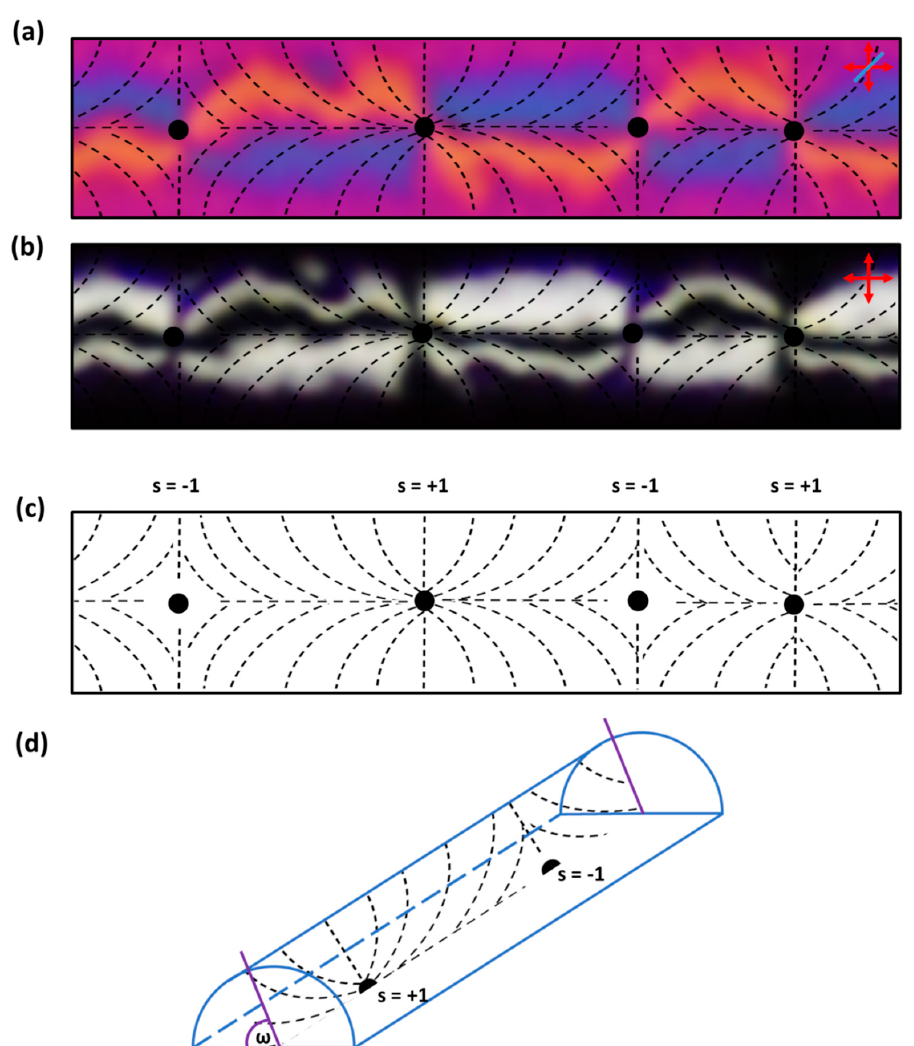
Figure 3. ( a – c ) show view from above of the escaped radial director field adopted by a nematic LC in a hemi ‐ cylindrical droplet, showing the alternation of s = +1 and s = − 1 point defects. With this director field, it is possible for anchoring to be planar at the glass and perpendicular at the air interface. In ( a ), the blue line indicates the orientation of the slow axis of the compensator. As shown in ( d ), for a hemi ‐ cylinder, the director field remains the same, ω = 0° to ω = 180°.